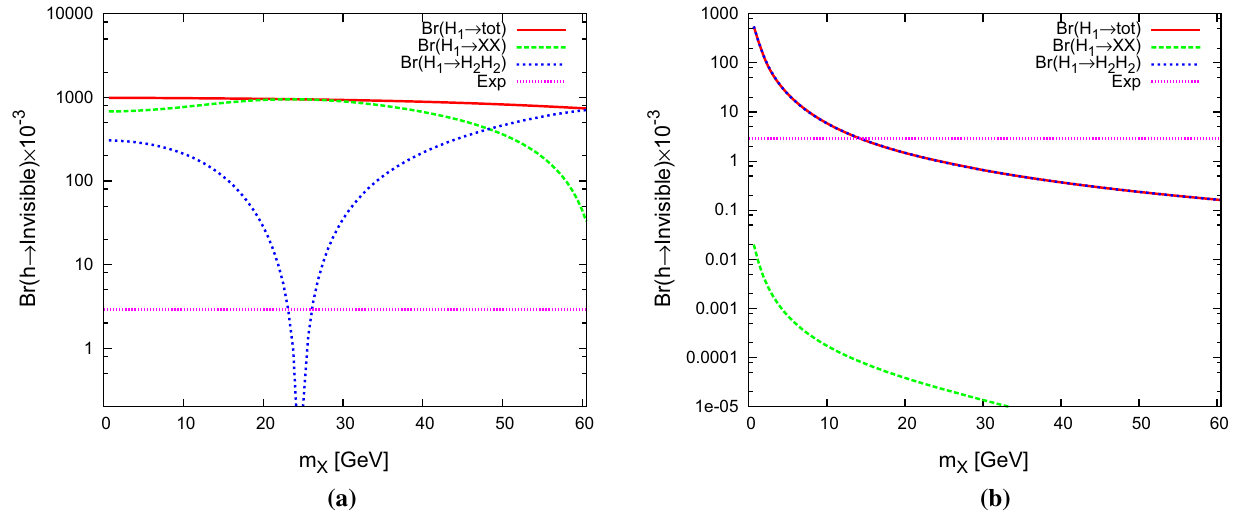
Fig. 13 a , b Different contributions of Br ( H 1 → Invisible ) as a function of the fermionic DM mass for g = 0 . 1 (g=0.0005) and M s = 500 GeV